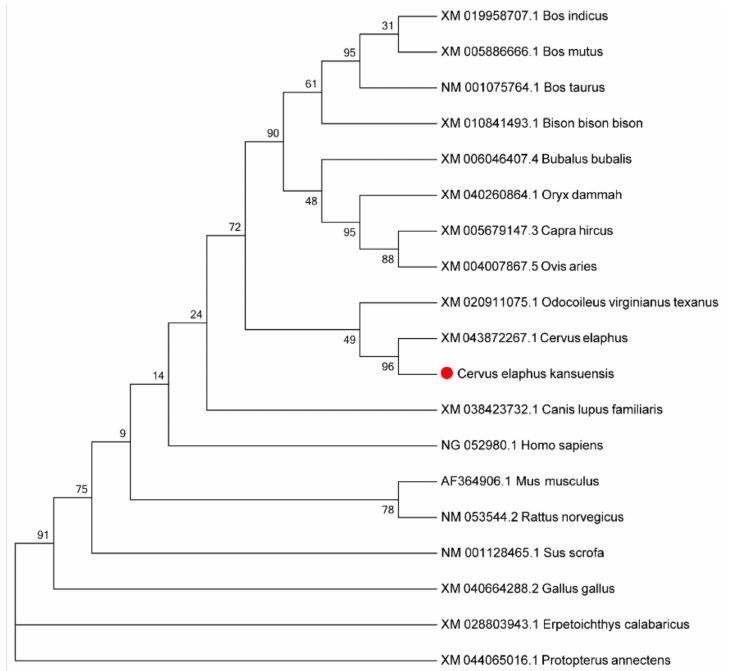
Figure 15. Phylogenetic tree analysis of C. elaphus kansuensis SFRP4 with other species. The tree was constructed using a matrix based on protein sequences and the program MEGA 7